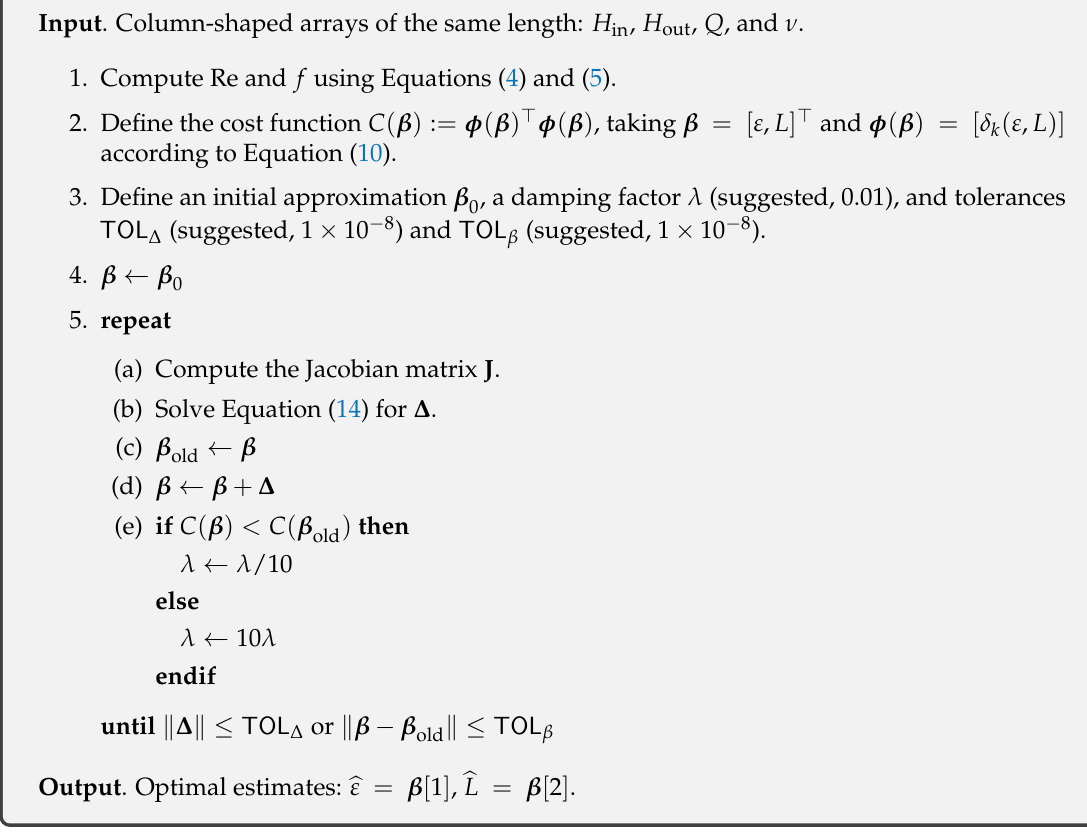
Figure 2. Algorithm to compute the optimal estimates of the roughness and minor loss